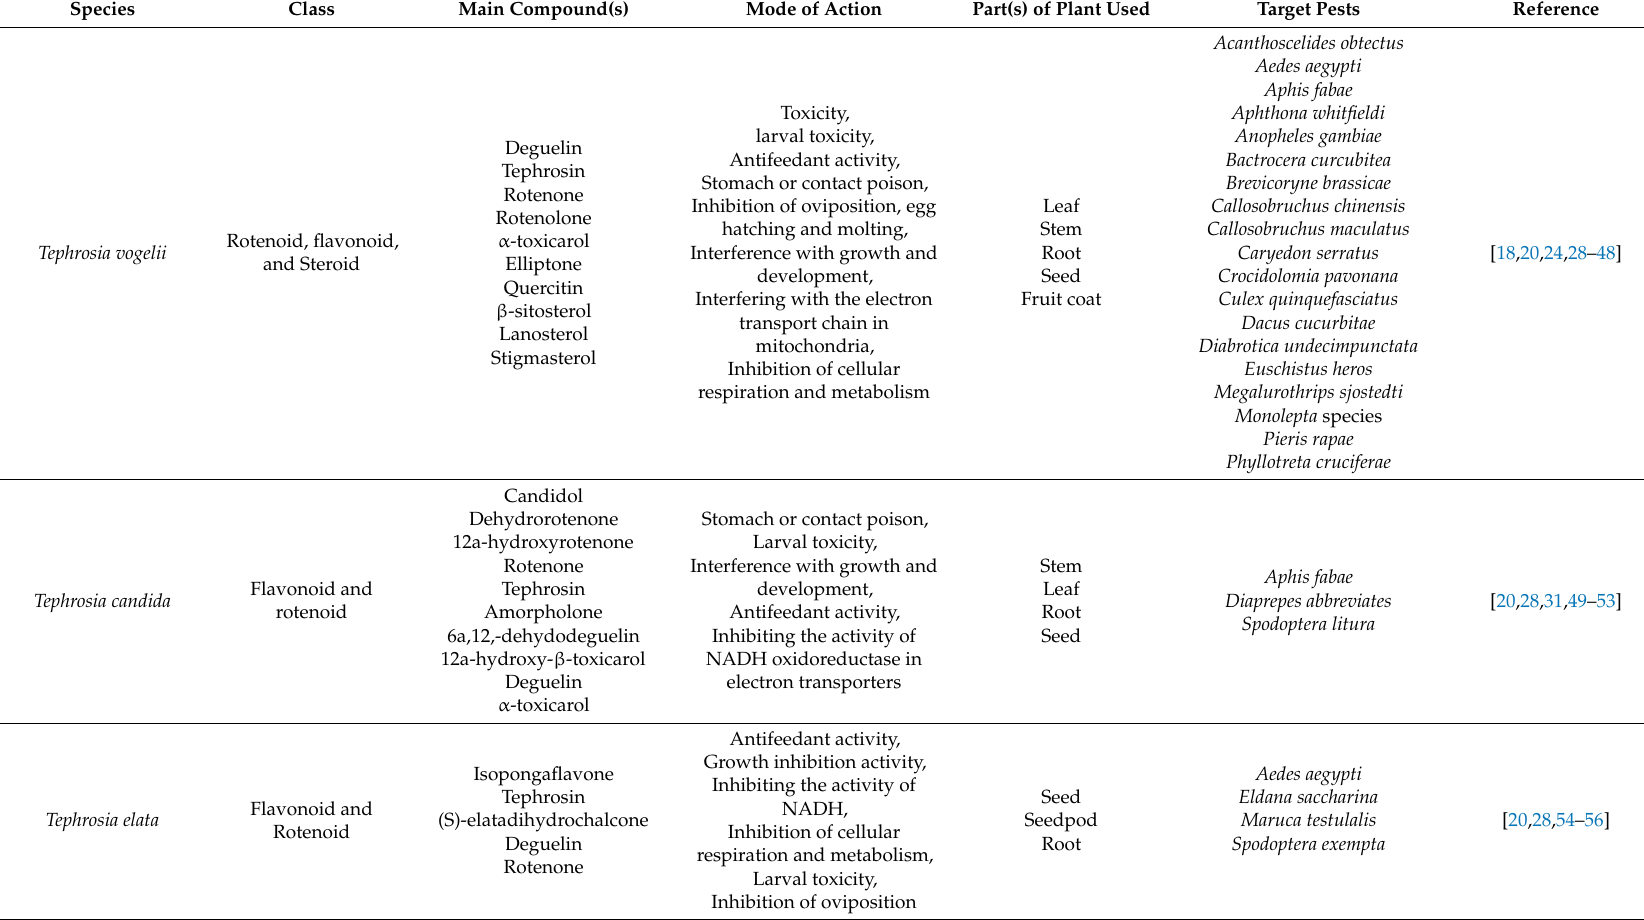
Table 1. Chemical constituents in some species of Tephrosia and their insecticidal